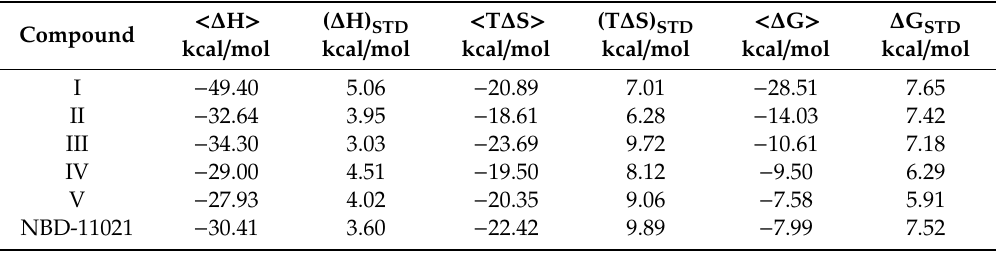
Table 4. Mean values of binding free energy < ∆ G > for the complexes of the CD4-mimetic candidates and NBD-11021 with gp120 and their standard deviations ∆ G STD 1 .